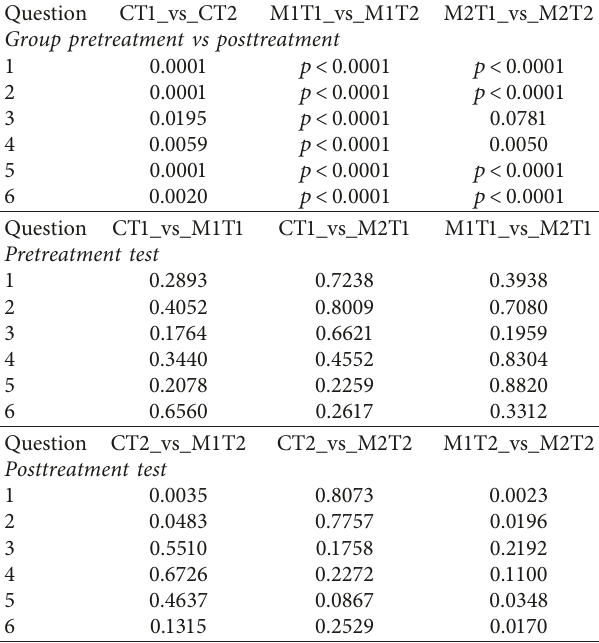
Table 3: p values of the Wilcoxon signed-rank